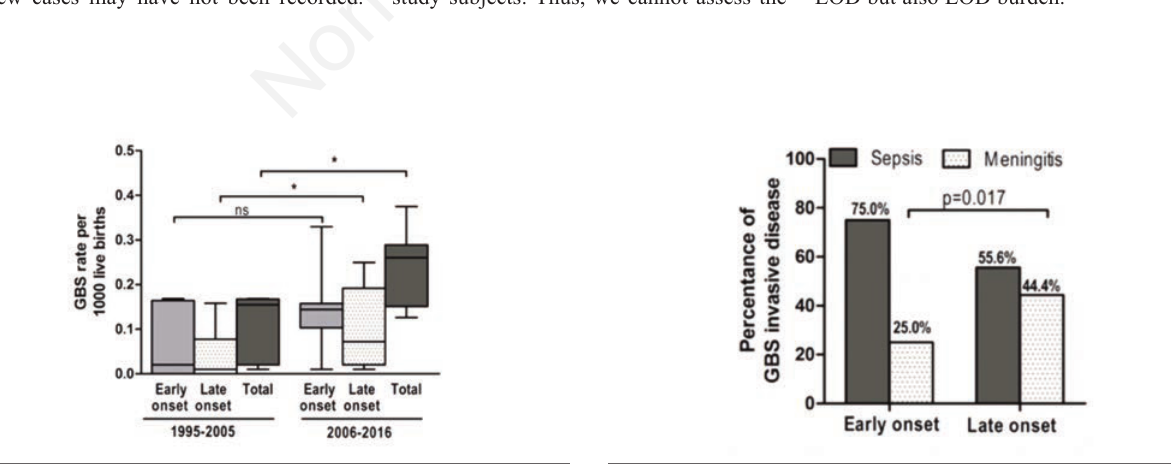
Figure 3. Percentage of Group B Streptococcus (GBS) invasive disease (sepsis and meningitis) in infants born to Crete the last